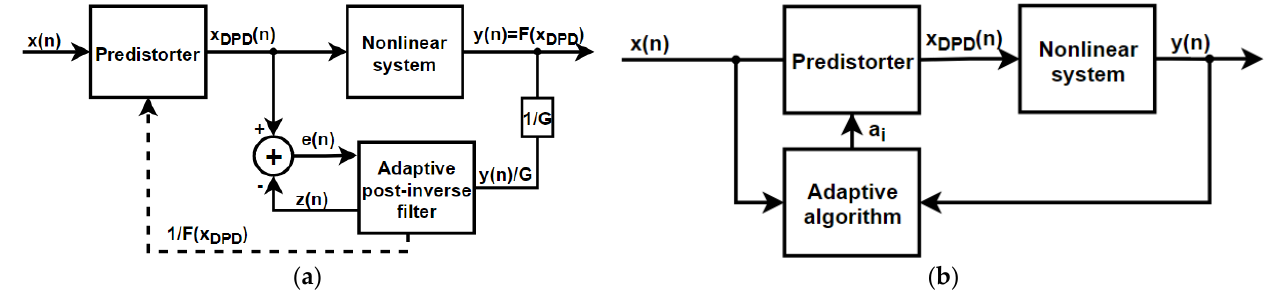
Figure 10. ( a ) indirect learning architecture ( b ) direct learning architecture.